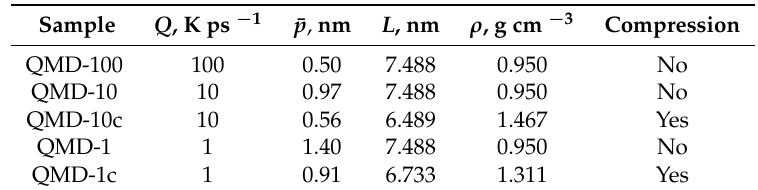
Table 1. Summary of sample structures. Models are named ‘QMD-x’ where ‘x’ is the quench rate used to produce it (in units of 1Kps − 1 –100Kps − 1 ). A ‘c’ is appended to the name if a post-quench compression step was included. Q : Quench rate, Kps − 1 ; ¯ p : mean pore size, nm; L : Box length, nm; ρ : Particle density, gcm − 3